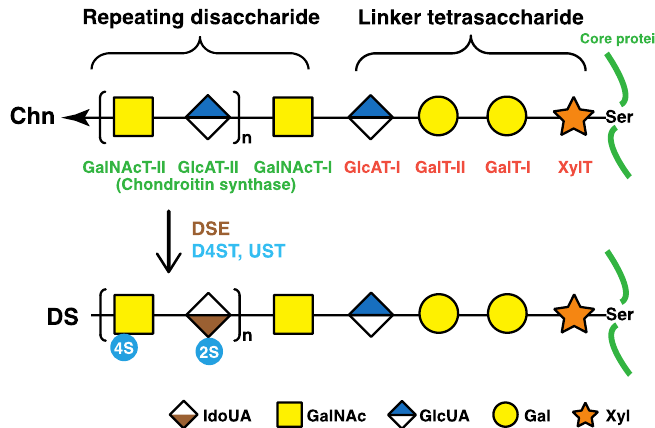
Figure 2. Biosynthetic assembly of DS chains by various glycosyltransferases, epimerases, and sulfotransferases. After specific core proteins are synthesized, the common glycosaminoglycan–protein linker region, GlcUA β 1-3Gal β 1-3Gal β 1-4Xyl β 1-, is built up by XylT, GalT-I, GalT-II, and GlcAT-I on the specific serine (Ser) residue(s) of core proteins. These four groups of enzymes are common to the biosynthesis of glycosaminoglycans including DS, CS, and heparan sulfate. After the formation of the linker region, chondroitin synthases assemble the chondroitin backbone. Thereafter, the epimerization of some GlcUA residues and sulfation of each sugar residue are catalyzed by DSE and D4ST as well as UST, and